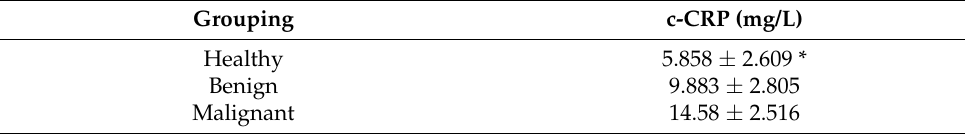
Table 4. Comparison of serum c-CRP levels between the different groups.